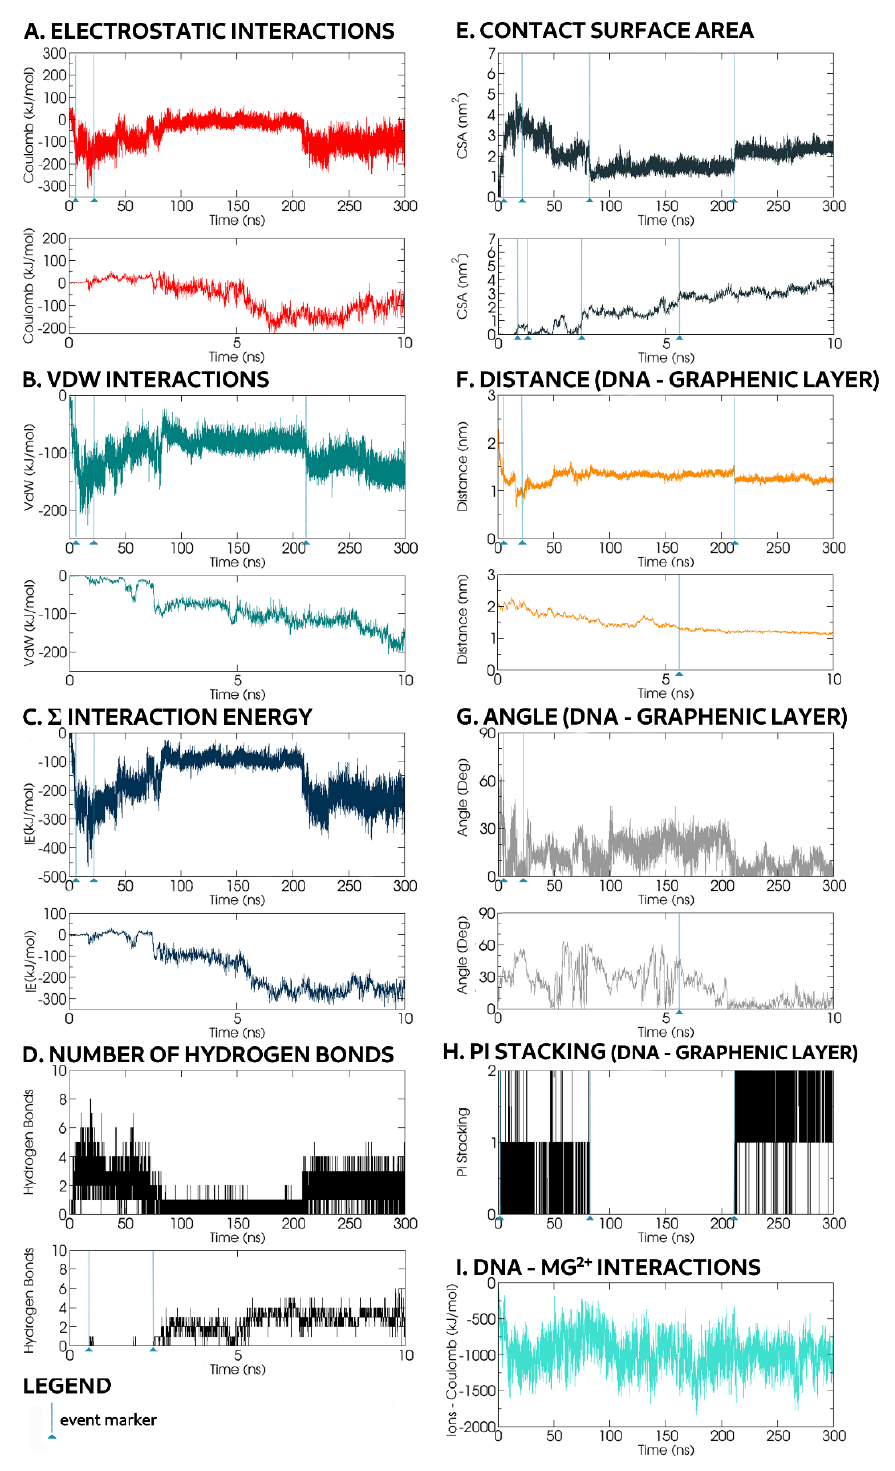
Figure 6. Evolution of different parameters over the 300 ns simulation time: ( A ) Electrostatic interactions between GO and ssDNA; ( B ) VdW interactions between GO and ssDNA; ( C ) Interaction energy between GO and ssDNA; ( D ) Hydrogen bonds formed between GO and ssDNA; ( E ) Contact surface area between GO and ssDNA; ( F ) Distance between the ssDNA molecule and the graphene layer; ( G ) Angle between the ssDNA molecule and the graphenic layer; ( H ) π–π stacking between ssDNA and the graphenic layer; ( I ) Electrostatic interactions between the ssDNA molecules and Mg 2+ ions within 1.4 nm of both the ssDNA and the GO.